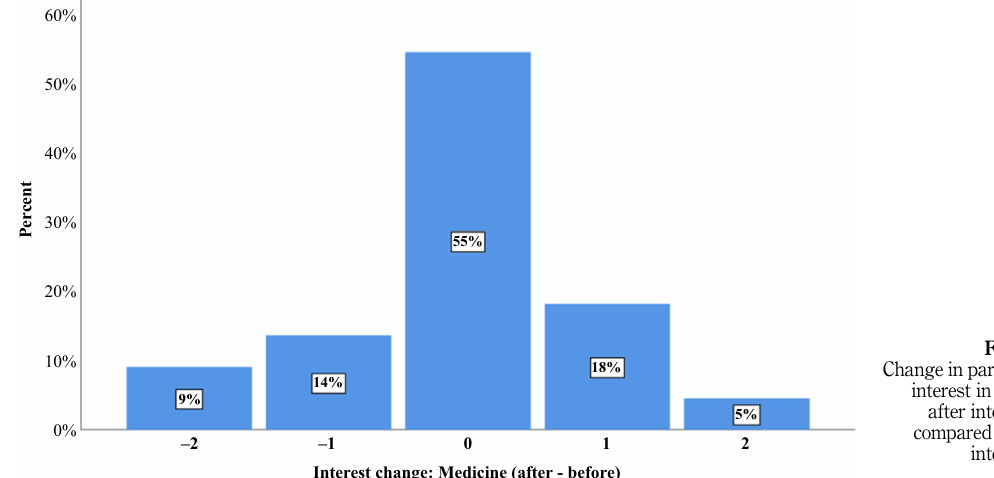
Figure 1. Change in participants ’ interest in medicine after